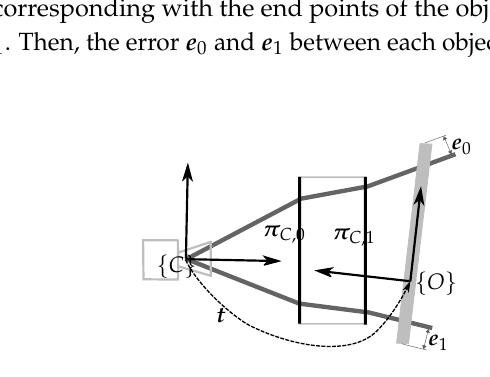
Figure 7. Illustration of the camera viewport calibration error for an object with two 3D points.